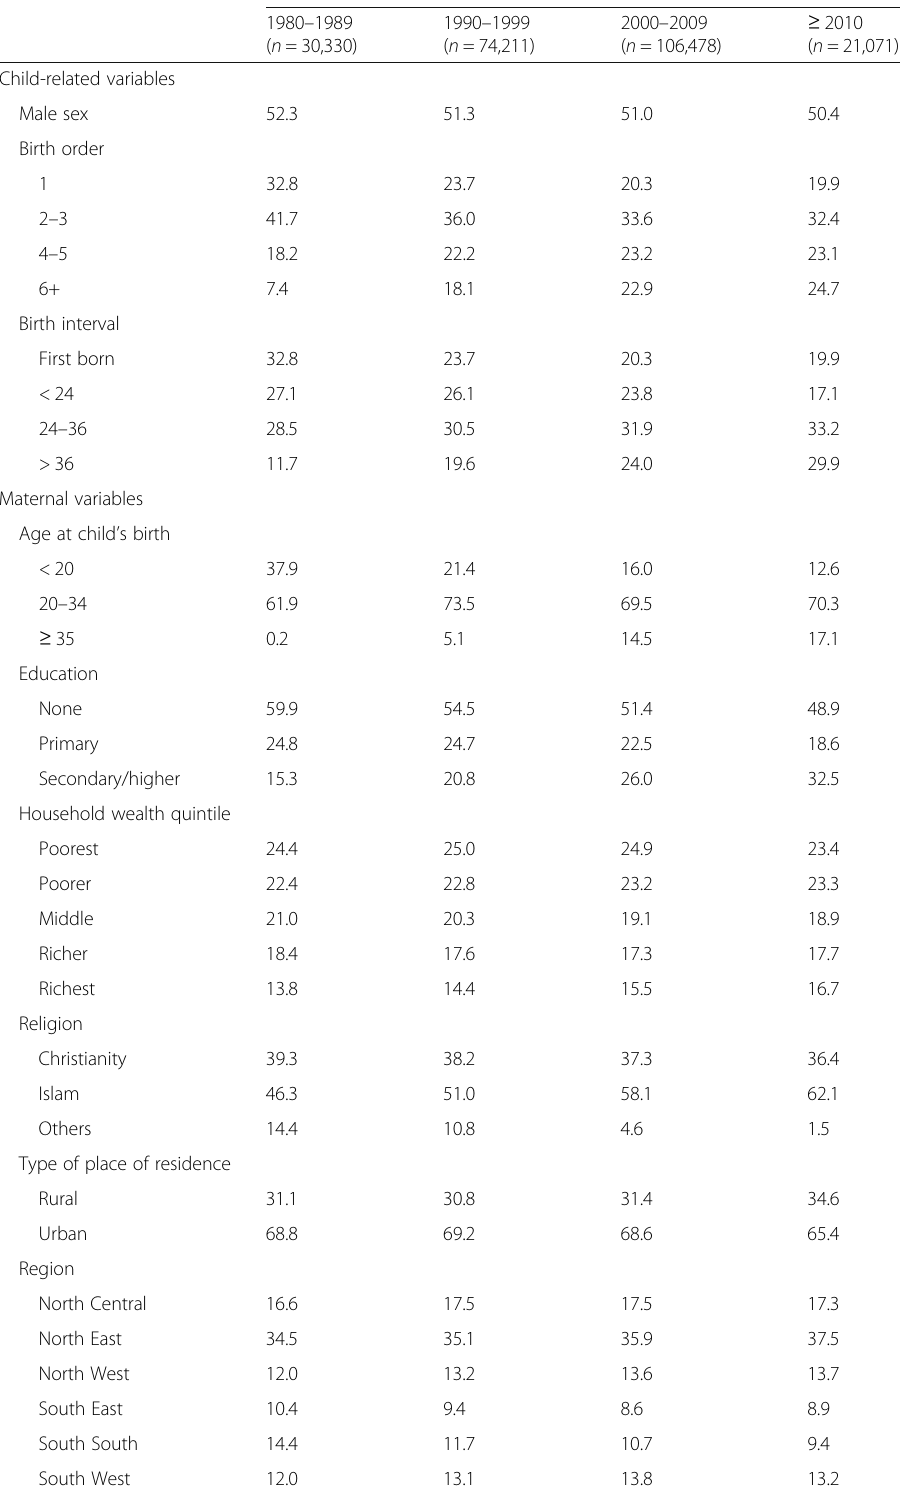
Table 1 Background characteristics of births, Nigeria, 1980 – 2013